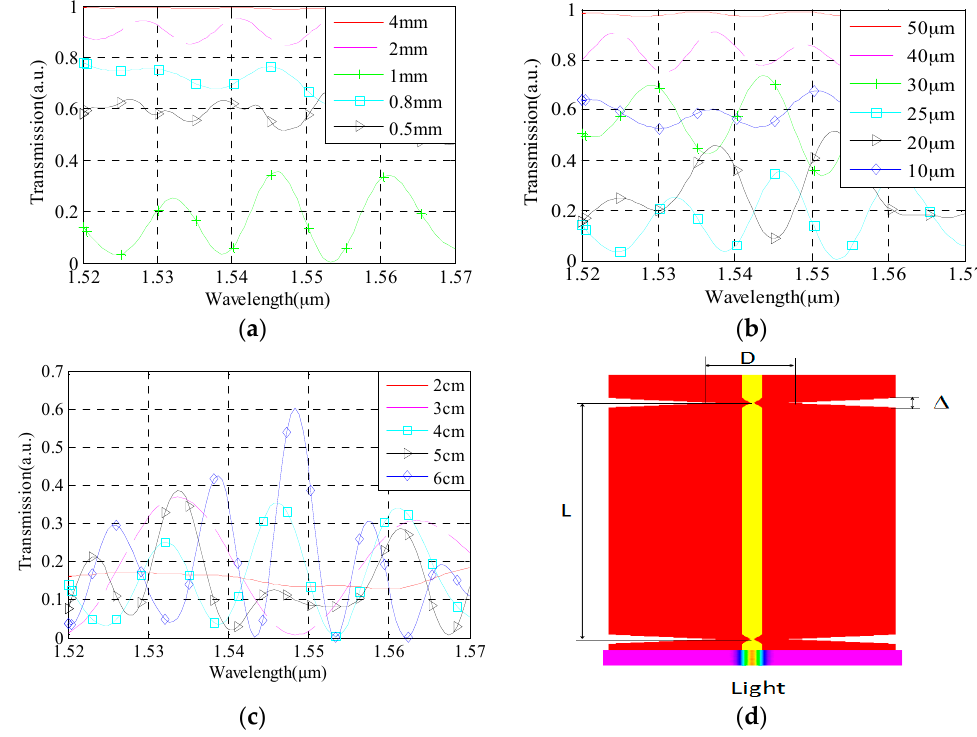
Figure 3. The simulation model and interference spectrum with different structural parameters. ( a ) Different taper area length ∆ ; ( b ) Different taper waist diameter D; ( c ) Different cone distance L corresponding; ( d ) The simulation model.